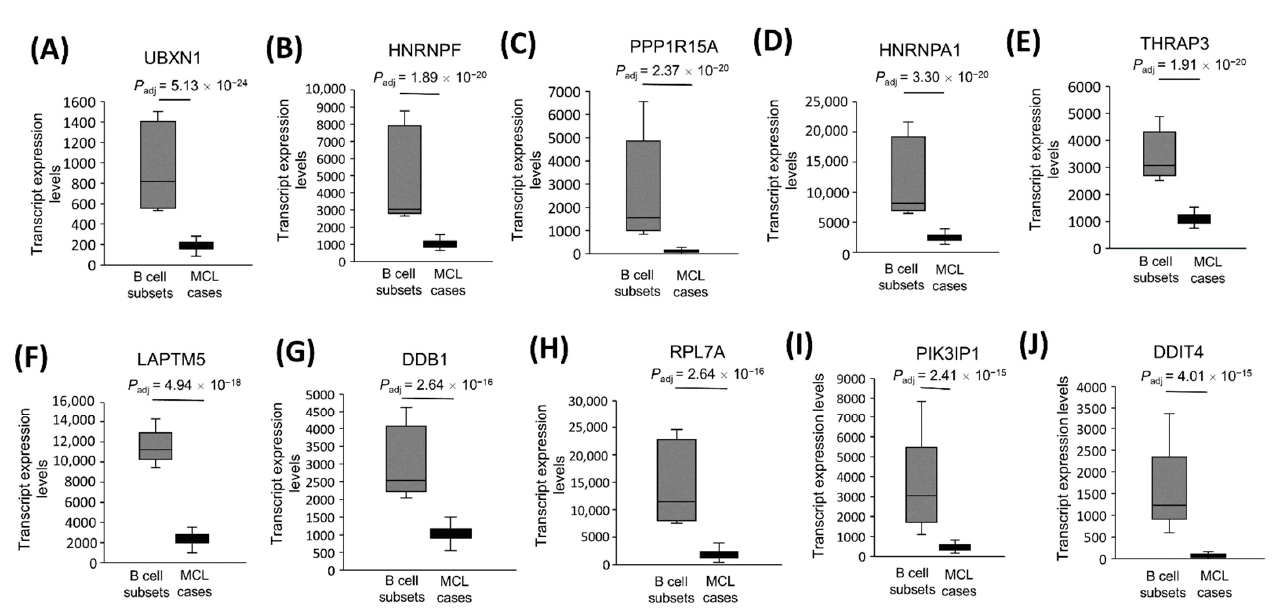
Figure 6. The transcript expression levels of the 10 most significantly downregulated tumor sup- pressor candidates in MCL. Tumor suppressor candidate transcript expression levels that are most significantly downregulated are shown for 32 MCL samples and 5 reactive tonsil B-cell subset sam- ples as box-and-whisker plots in the statistical significance order ( A–J ). Adjusted p values show the statistical significance of expression differences between MCL and the control samples.